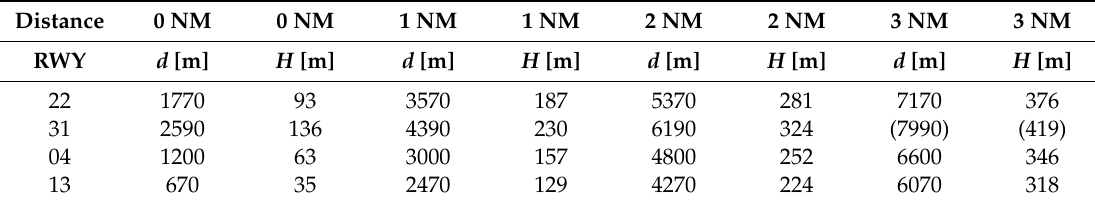
Table 1. Distances and altitudes of the reference points (marked as crosses) relative to the lidar position in the lidar snapshots. Abbreviations: RWY = Runway, 0 NM = runway end, d —horizontal distance from the lidar, H —altitude over the surrounding